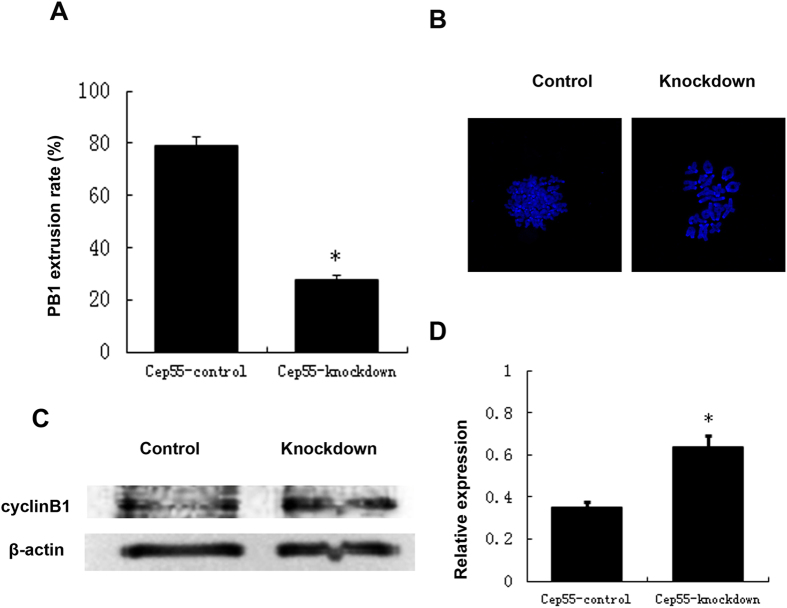
Cep55 knockdown causes increase of cyclin B1 level, non-segregation of homologous chromosomes, and failure of PB1 extrusion.After microinjection of Cep55 siRNA or control siRNA, the oocytes were placed in M16 containing IBMX for 24 h, then washed 8 times and transferred into IBMX-free M16 medium for 14 h to observe meiotic cell cycle progression. (A) Percentages of first polar body extrusion in the knockdown group and control group. Data are presented as means ± SEM of 4 independent experiments (*p < 0.01). (B) Failure of homologous chromosome segregation after Cep55 knockdown. The ratio of tetrads is 35/44 in the Cep55 knockdown and 7/41 in the control group. (C) Higher cyclin B1 level in Cep55 knockdown oocytes. Oocytes of the Cep55 knockdown group and control group were cultured in IBMX-free medium for 9.5 h, followed by western blotting. (D) The relative expression level of cyclin B1 after Cep55 knockdown. Data are presented as means + -SEM of 3 independent experiments (p < 0.05).